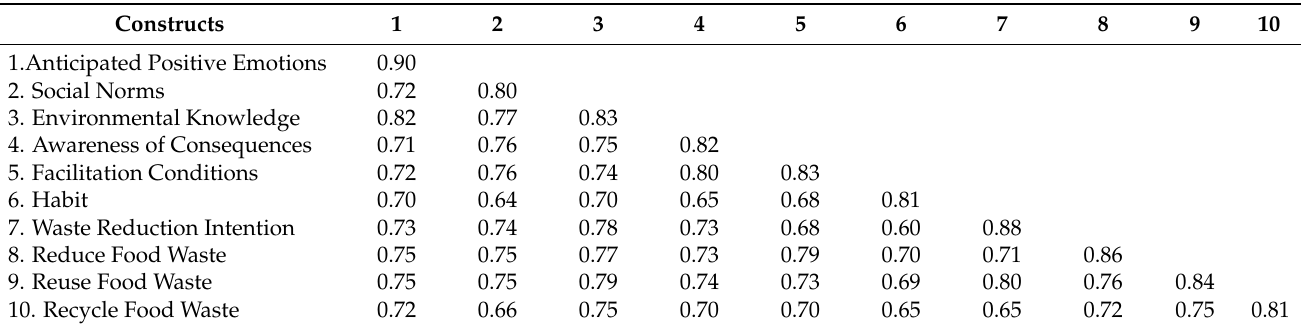
Table 3. Discriminant Validity Analysis.